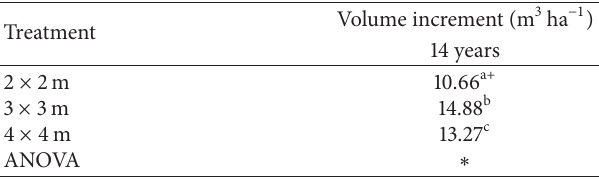
Table 2: Effect of spacing on volume increment of T. grandis at